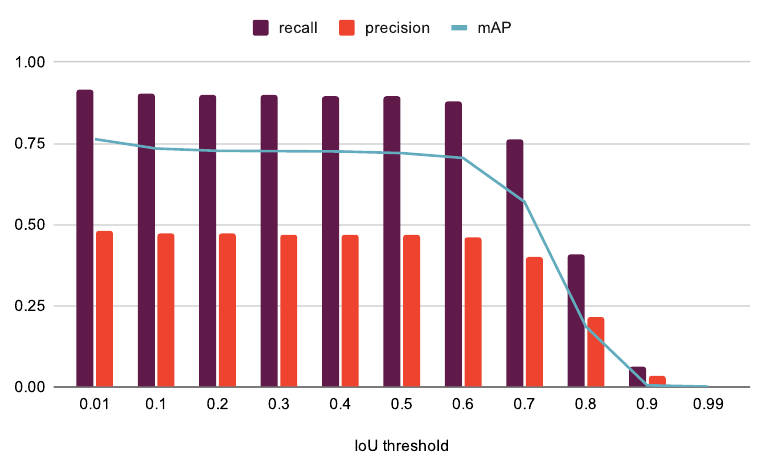
Figure 9. IoU threshold influence on model performance (YOLOv3 trained with the ’divided’ dataset, results for validation